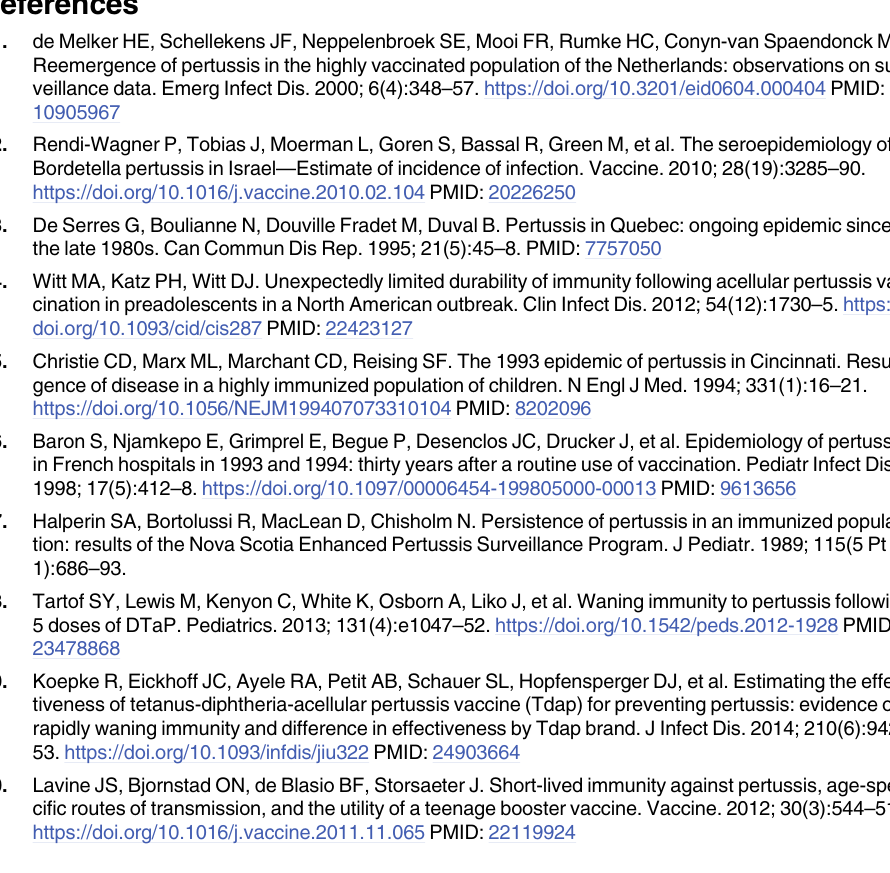
S2 Table. Crystallographic data collection and refinement